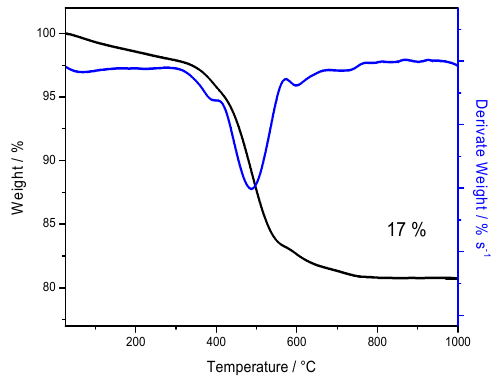
Figure 2. Thermo-gravimetric (black curve) and derivative thermo-gravimetric (DTG, blue curve) analysis of TiO 2 -SO 4 powder.